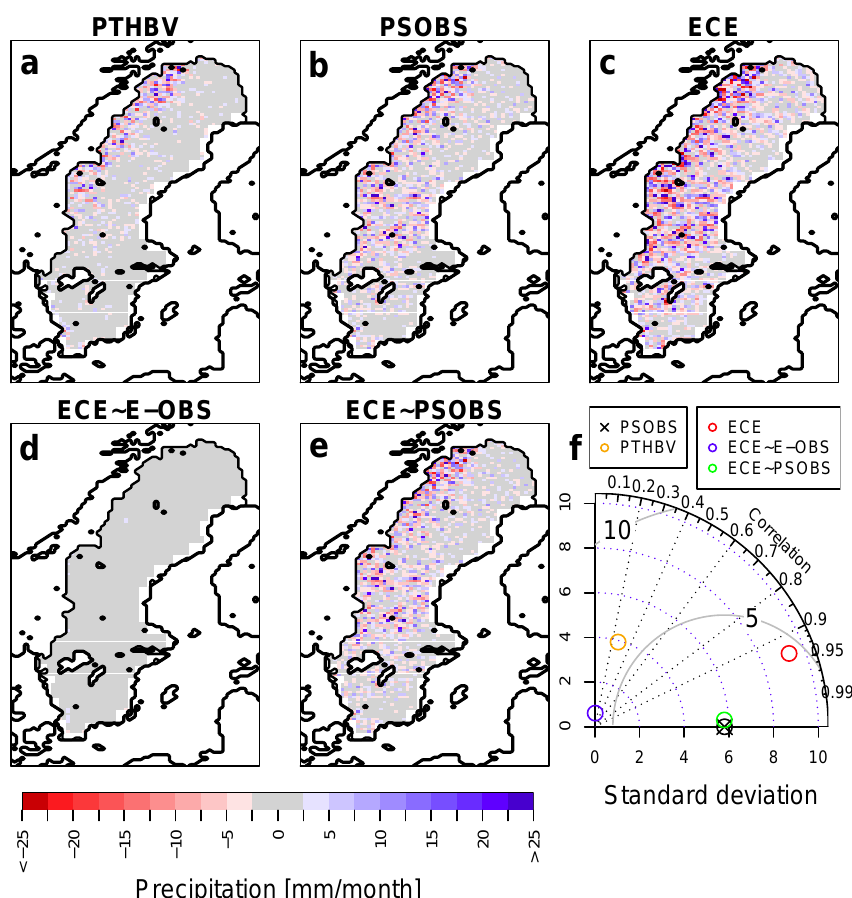
Figure 6. Small scale features of ( a ) PTHBV, ( b ) PSOBS, ( c ) ECE , ( d ) ECE ∼ E-OBS and ( e ) ECE ∼ PSOBS for summer, derived by subtracting a 9p spatial filtered field from each map of mean values. ( f ) A Taylor diagram shows the spatial correlation and standard deviation for each of the panels (a–e) with PSOBS as